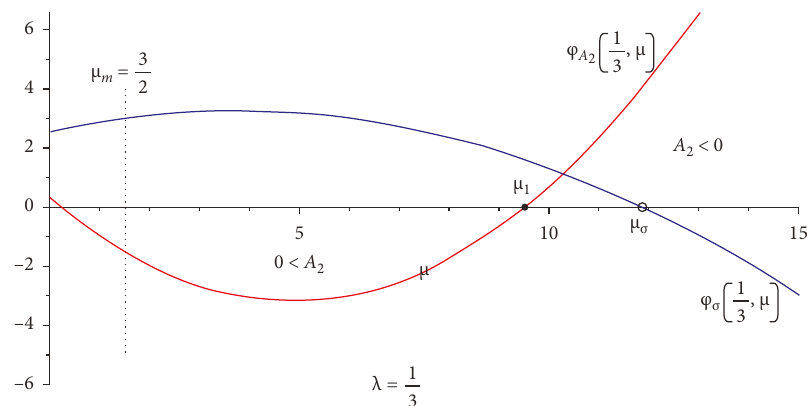
Figure 4: Curves of functions φ